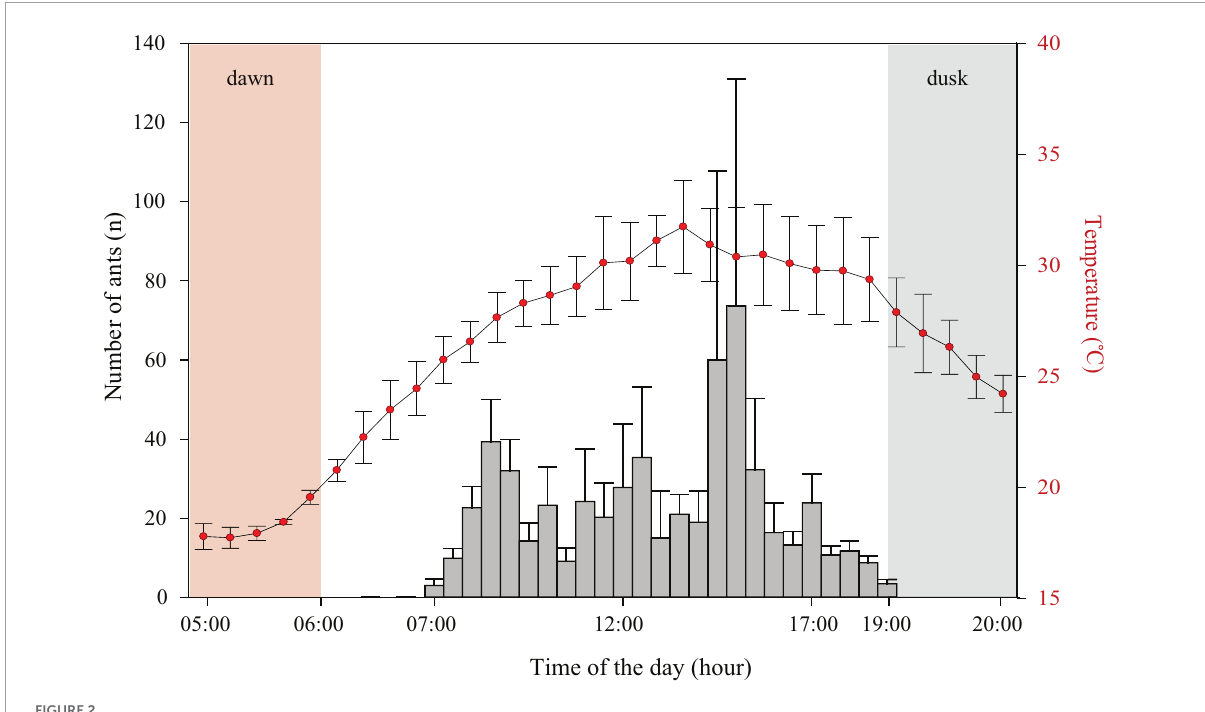
FIGURE2 Activity rhythm. The activity period of Camponotus fulvopilosus foragers (bars) and air temperature measurements (red dots). Error bars represent standard